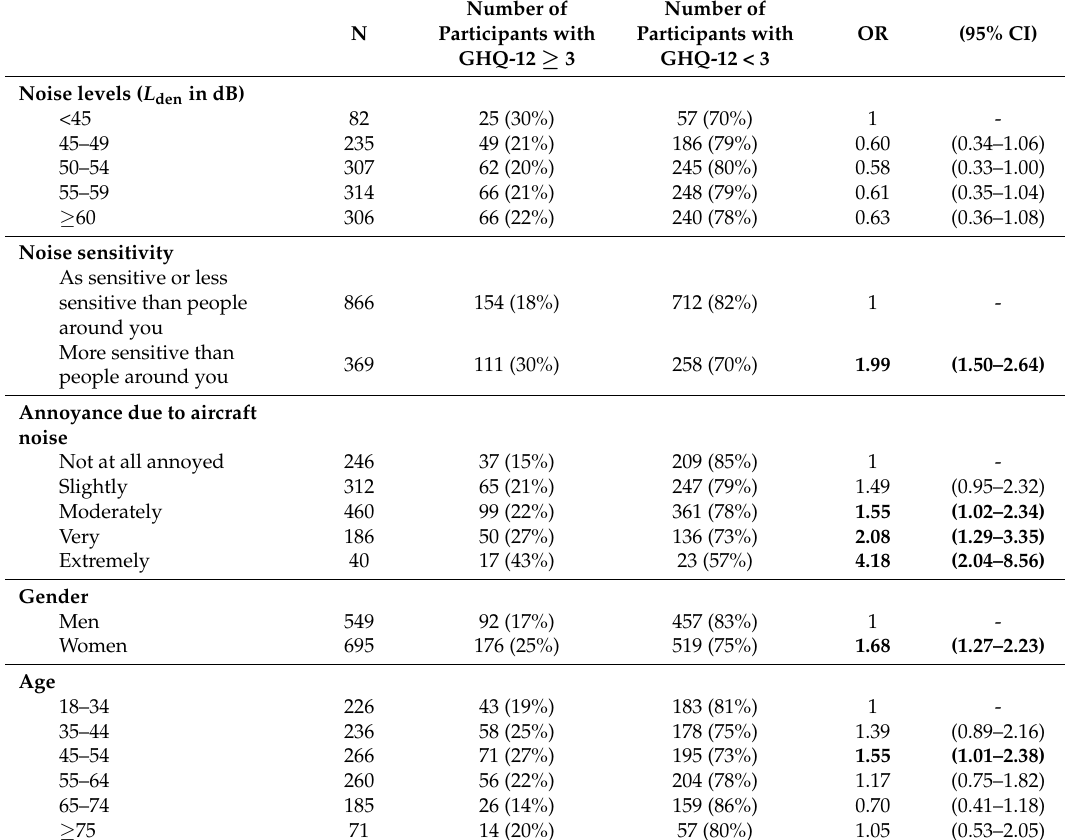
Table 2. Odds ratios (ORs) for psychological ill-health in relation to major confounders in univariate logistic models.